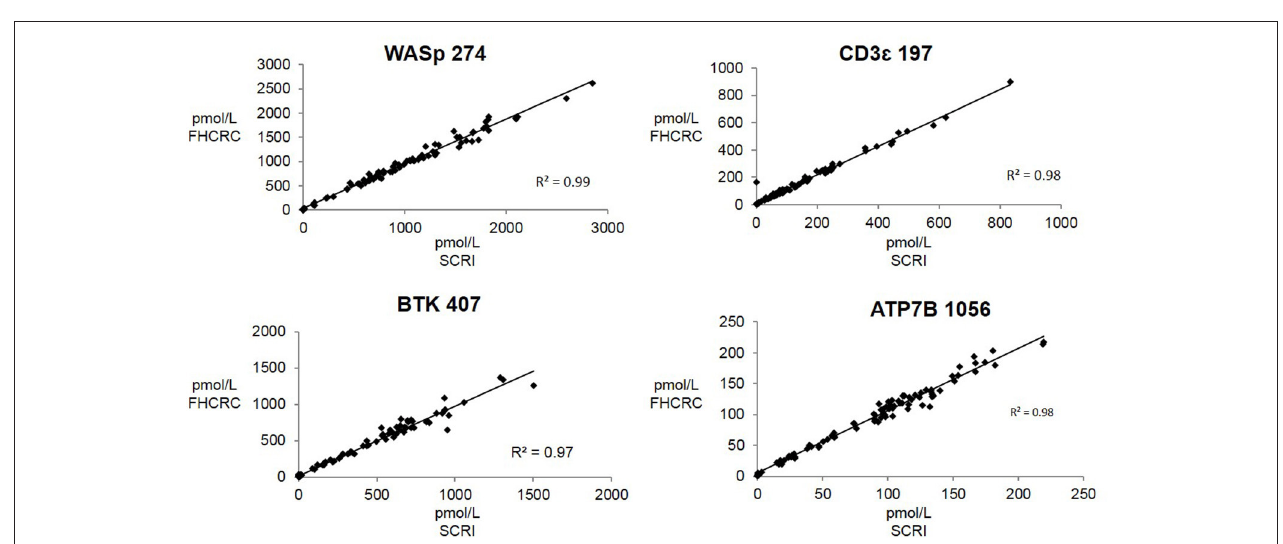
FIGURE 3 | Inter-laboratory correlation in measured PIDD peptide concentrations. SCRI, Seattle Children’s Research Institute; FHCRC, Fred Hutchinson Cancer Research Center.